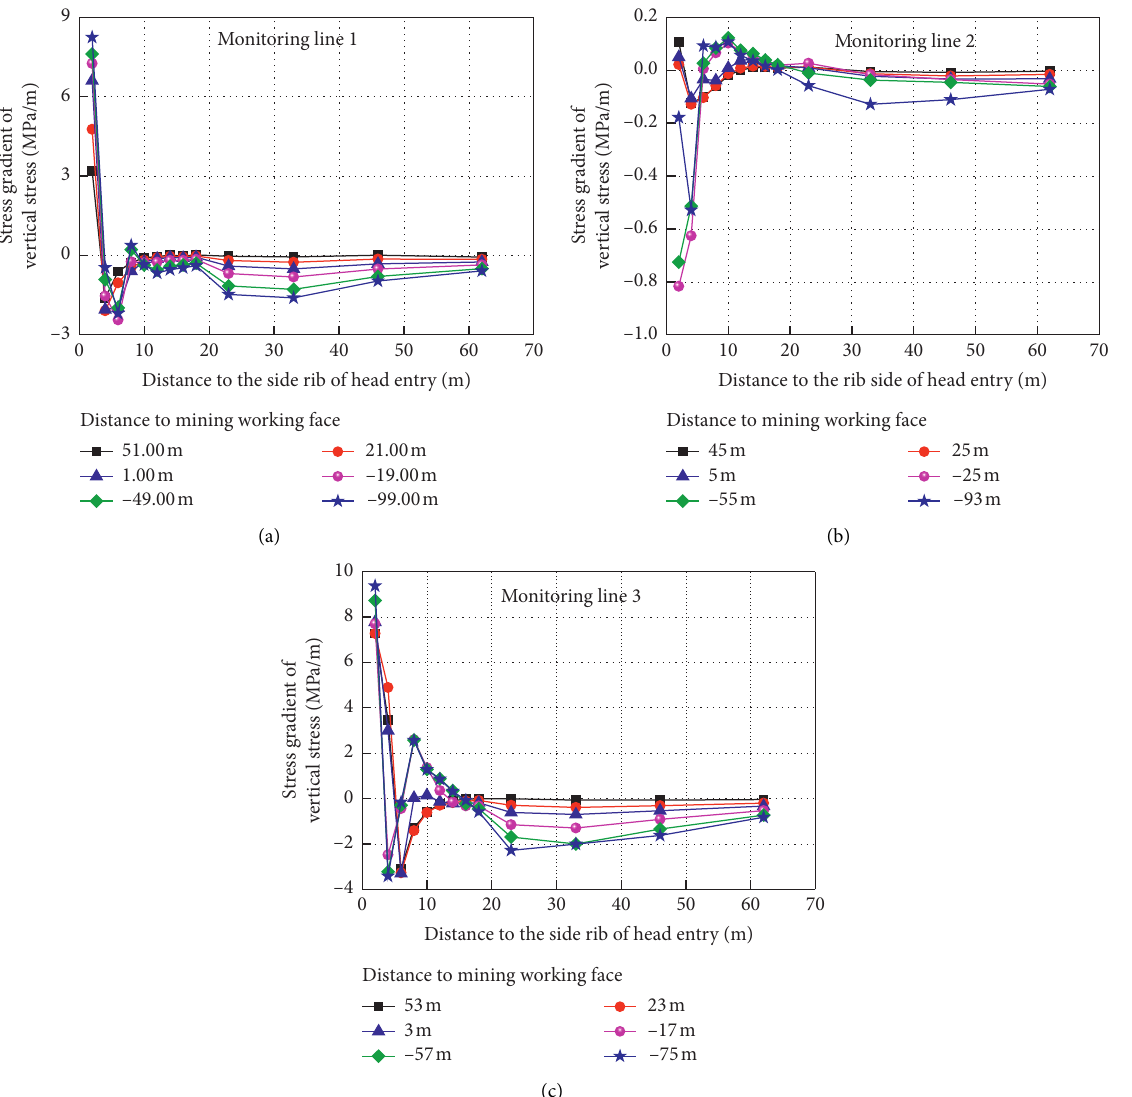
Figure 9: Stress gradient of abnormal stress in lateral of the mining working face. (a) Monitoring line 1, (b) monitoring line 2, and (c) monitoring line